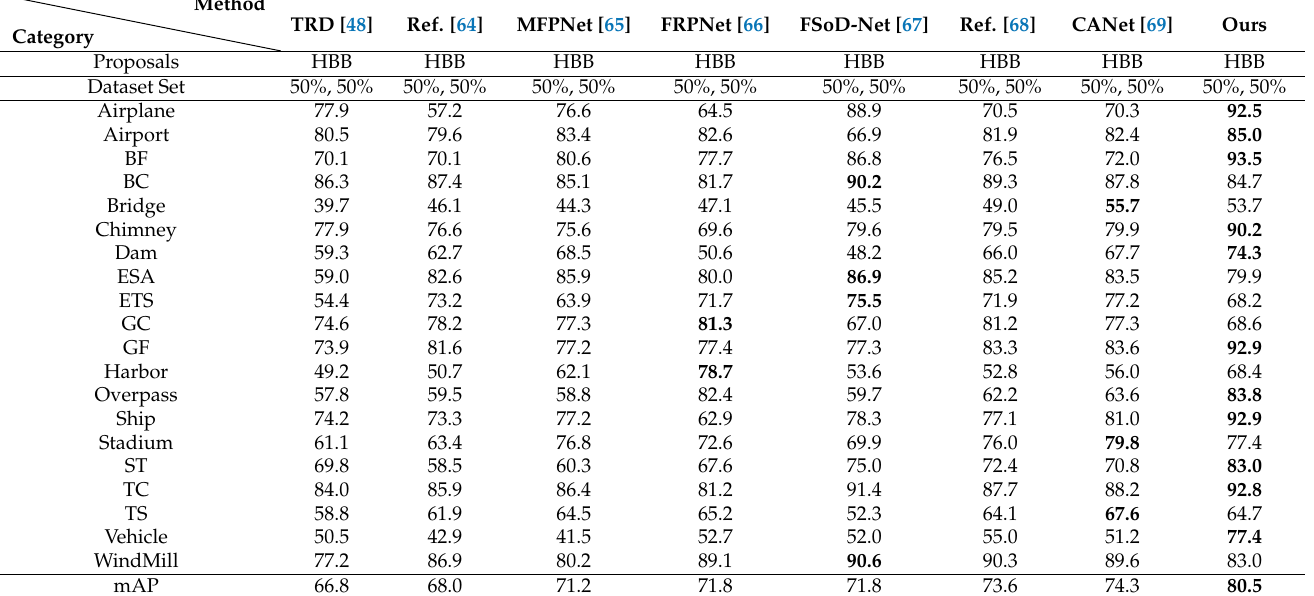
Table 1. The results of various detection algorithms on the DIOR dataset. The highest AP in each category is highlighted. The mAP ( × 100) represents IOU = 0.5. The Dataset Set represents the training set and test